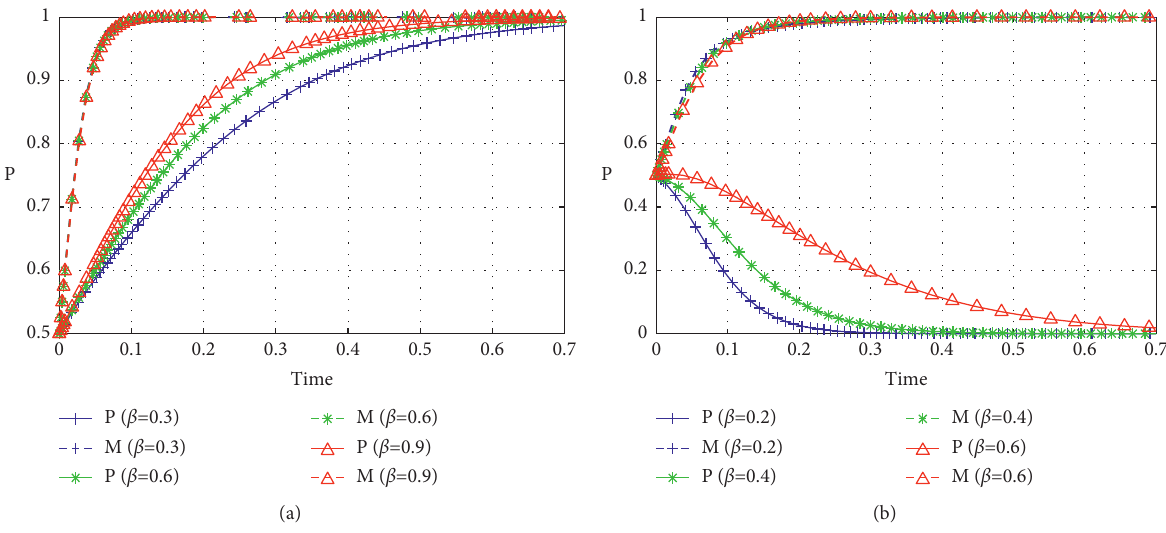
Figure 6: The impacts of the cost-sharing ratio in different cases. (a) Case 1. (b) Case